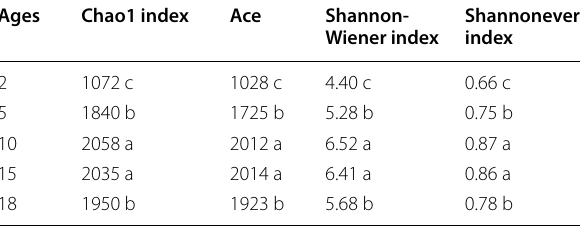
Table 3 Soil bacterial community diversity index of citrus tree orchards with different ages